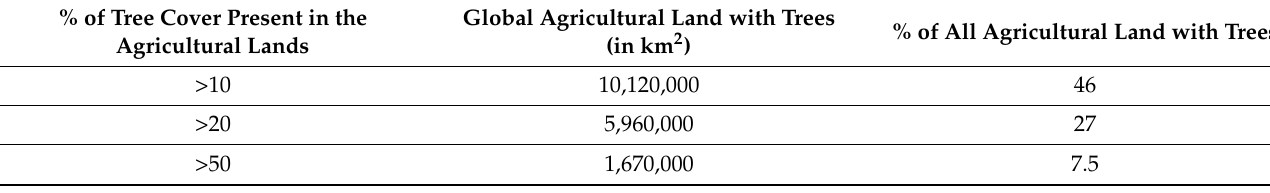
Table 1. Overview of global agroforestry